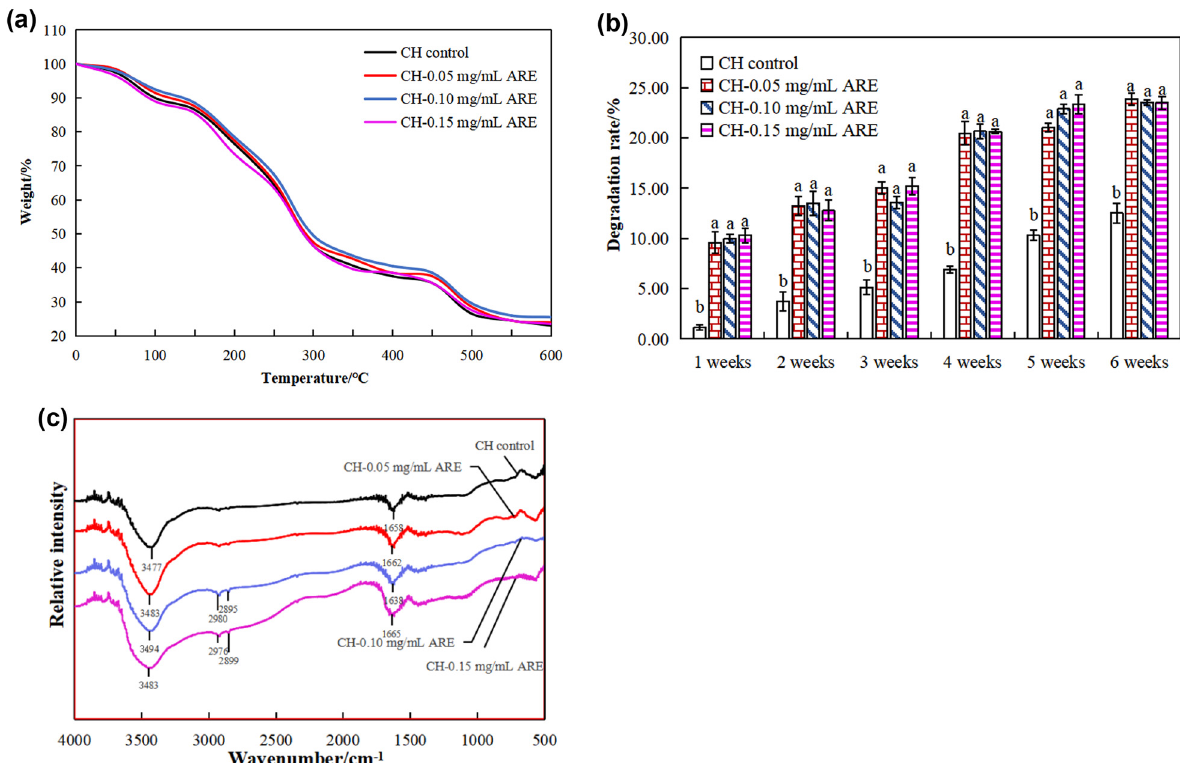
Figure 3: Biodegradability rate ( a ) , thermal properties ( b ) , and FTIR spectrum ( c ) of CH/ARE composite fi lms. Di ff erent letters are used to indicate the signi fi cance of the di ff erence between the composite fi lm samples in the same column ( p < 0.05 )